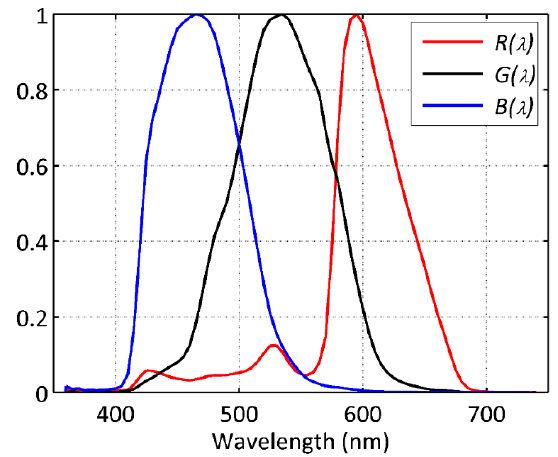
Figure 1. Human photoreceptor spectral sensitivity functions 𝐶𝑦(cid:4666)𝜆(cid:4667) , 𝑀𝑒(cid:4666)𝜆(cid:4667) , 𝑅ℎ(cid:4666)𝜆(cid:4667) , 𝐶ℎ(cid:4666)𝜆(cid:4667) , and 𝐸𝑟(cid:4666)𝜆(cid:4667) , with SI compliant normalization [17].